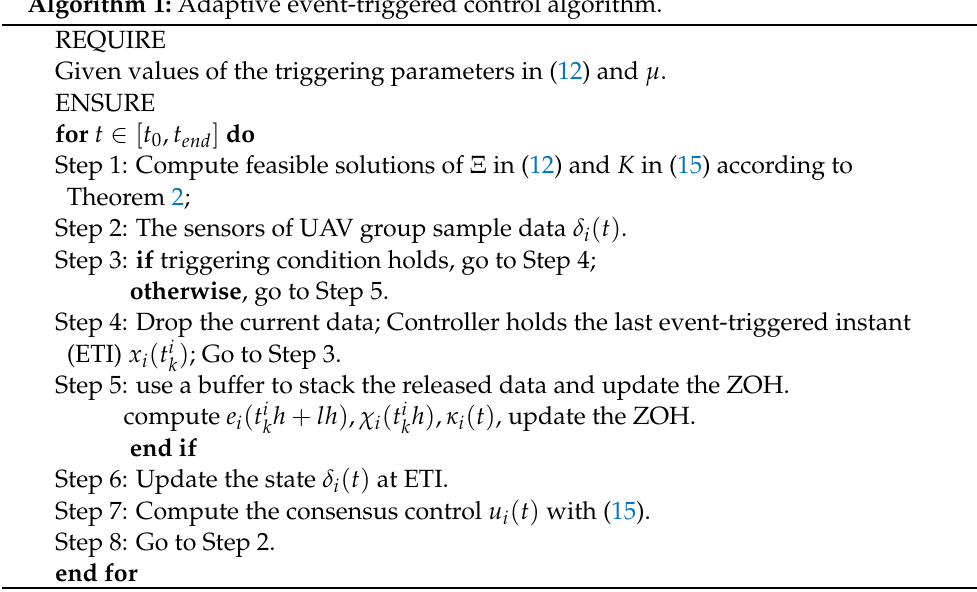
Algorithm 1: Adaptive event-triggered control